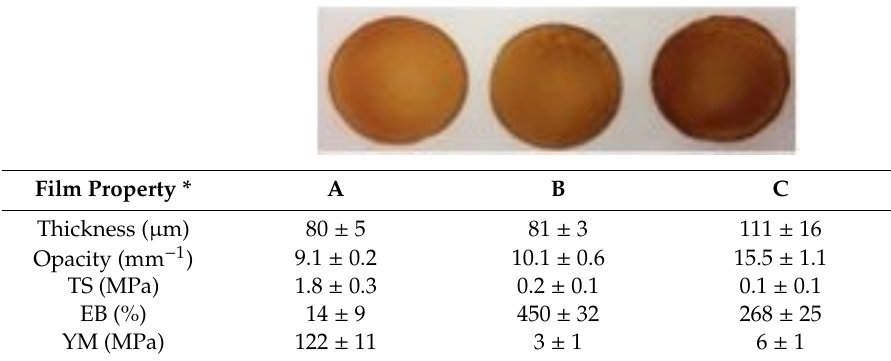
Table 1. Images and properties of films obtained at different pH values (A, pH 3.0; B, pH 3.5; C, pH 4.0) with 800 mg of dialyzed homopolypeptide preparation. Experimental details are given in the text.